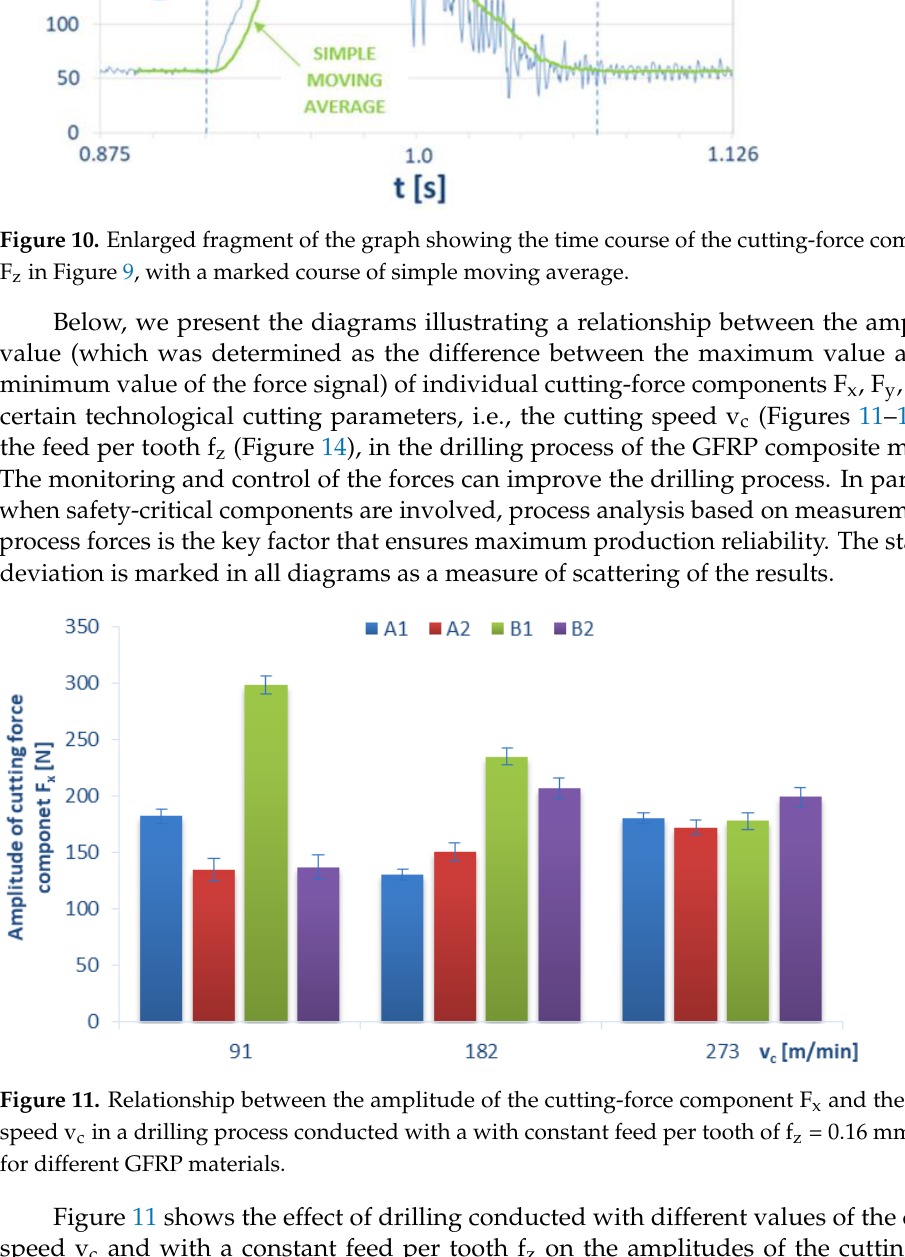
Figure 12. Relation between amplitude of cutting-force component F y and cutting speed v c , with constant feed per tooth f z = 0.16 mm/tooth for different GFRP materials. Figure 13. Relationship between the amplitude of cutting-force component F z and the cutting speed v c in a drilling process conducted with a with constant feed per tooth of f z = 0.16 mm/tooth for dif- ferent GFRP materials.